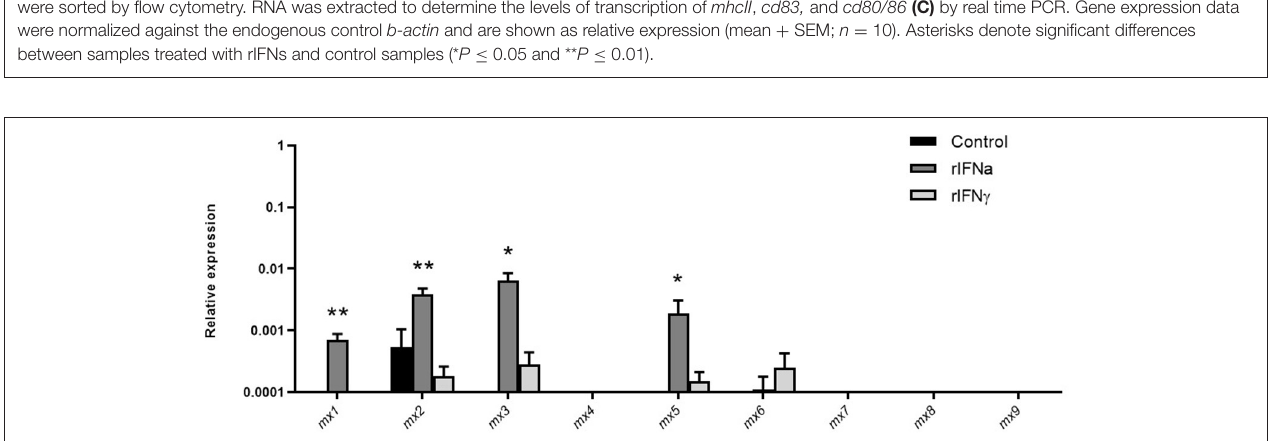
FIGURE 7 | Induction of mx transcription in blood IgM + IgD + B cells in response to type I or type II IFNs. Blood leukocytes were incubated with 50ng/ml rIFNa, 20ng/ml rIFN γ or media alone (control) at 20 ◦ C. After 24h, IgM + IgD + B cells were sorted by flow cytometry and RNA extracted to determine the levels of transcription of the different mx genes present in rainbow trout ( mx1 - mx9 ). Gene expression data were normalized against the endogenous control b-actin and are shown as relative expression (mean + SEM; n = 10). Asterisks denote significant differences between samples treated with rIFNs and control samples (* P ≤ 0.05 and ** P ≤